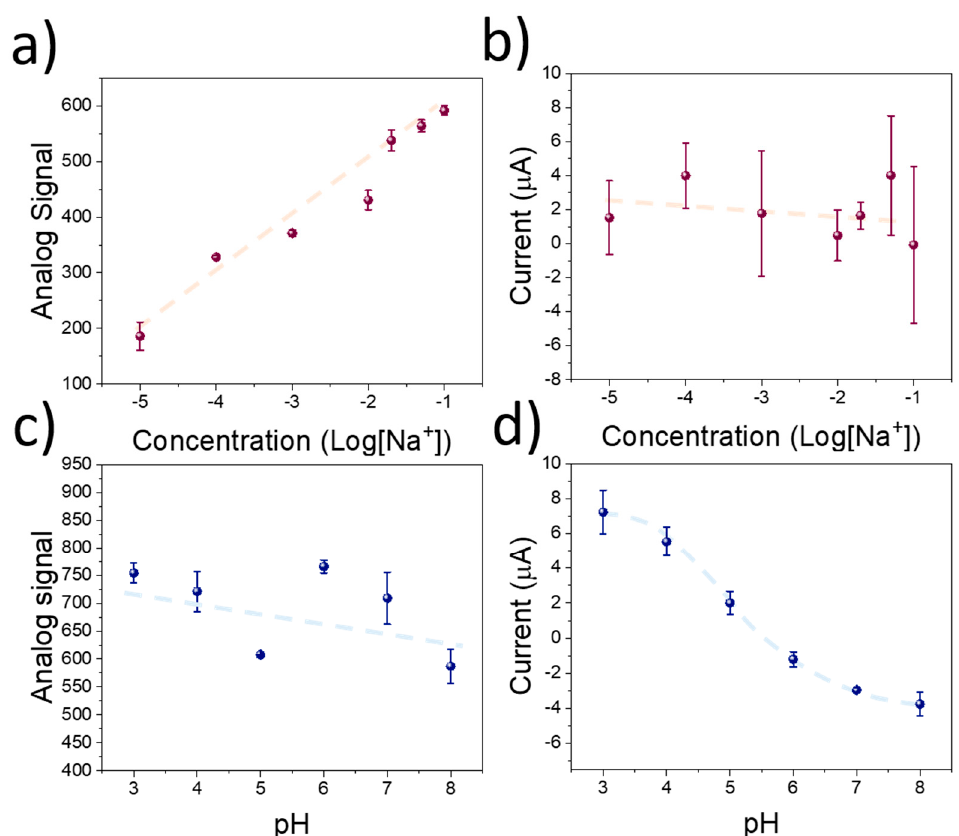
Figure 4. ( a ) Calibration plot of the microcontroller-based device using the screen-printed electrodes using different concentrations of KCl. ( b ) Amperometric signal recorded during the pulse voltammetry experiment using the RuO x − modified copper electrodes. ( c ) Potentiometric signal recorded during calibration of the sensing devices using KOH to increase the pH. ( d ) Corresponding amperometric signal recorded during the pulse voltametric experiment.